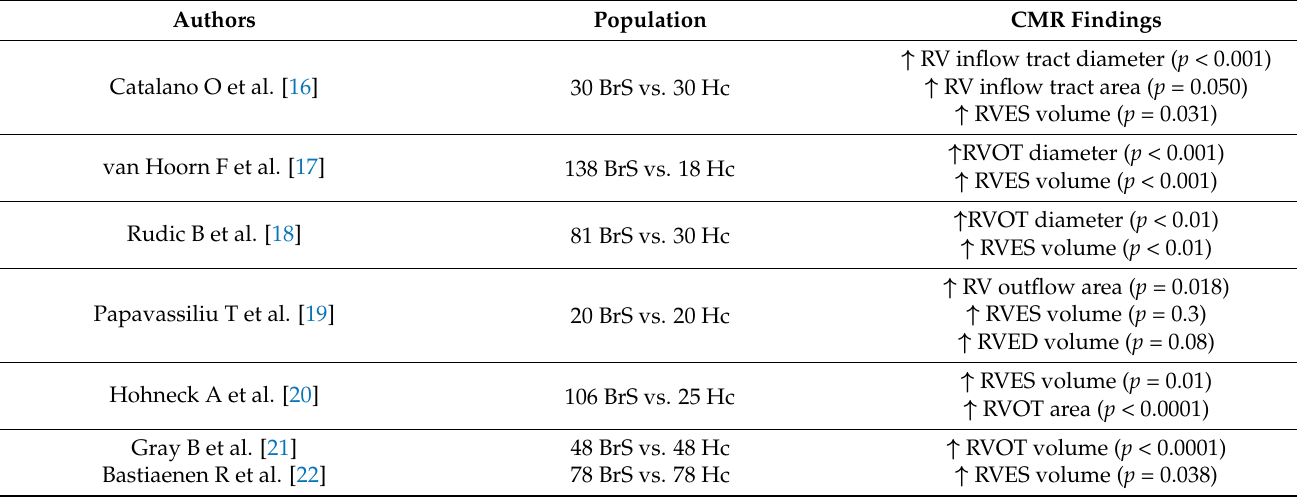
Table 3. CMR findings about RV dimension in BrS.